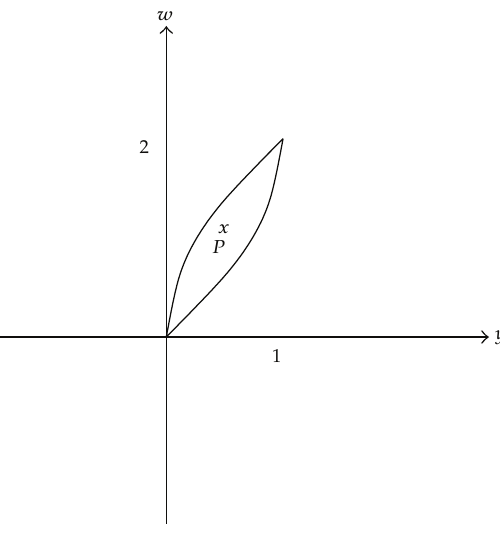
Figure 2: Spectral scale for b in Example 2.18.